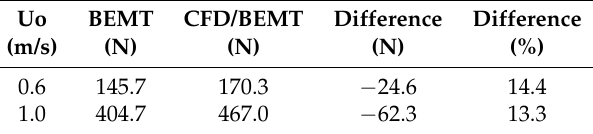
Table 6. Average turbine thrust.